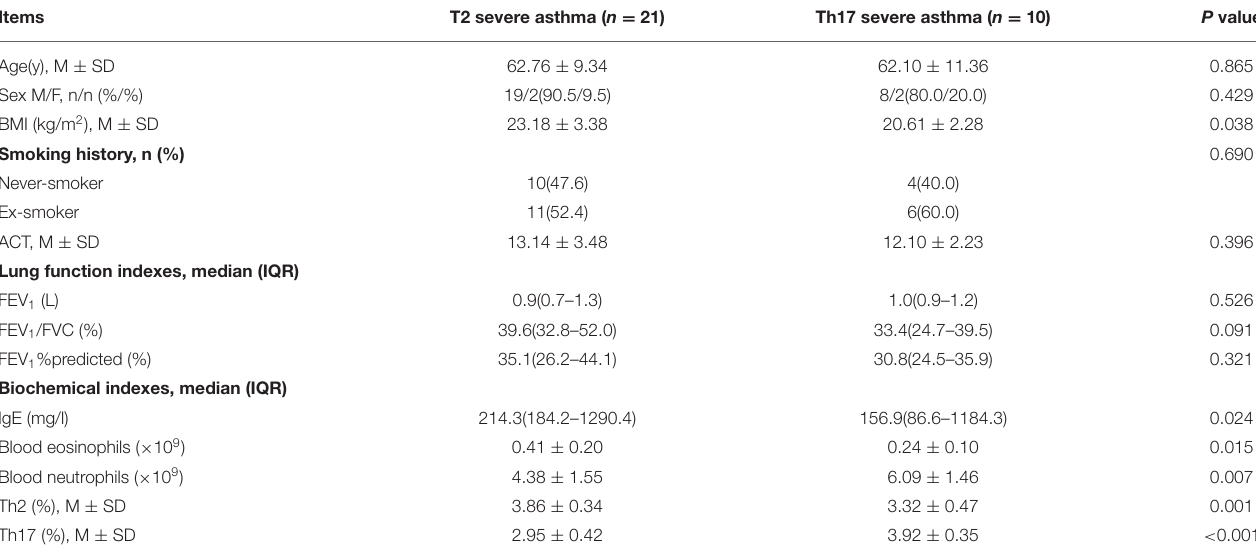
TABLE 2 | Clinical characteristics of T2 and Th17 severe asthma participants.